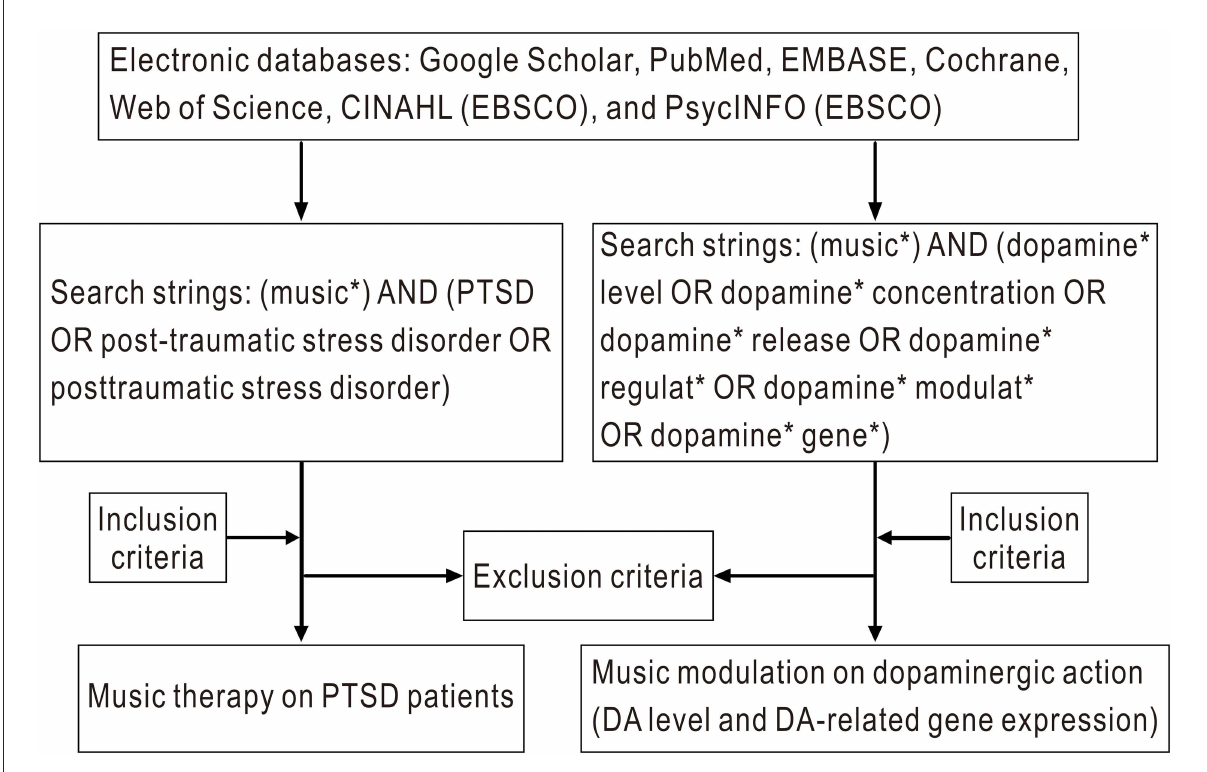
FIGURE1 Flow diagram detailing the primary steps of the literature